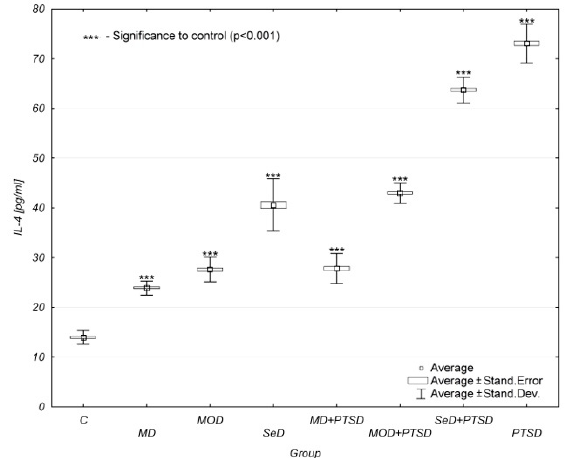
Figure 3. Mean IL-4 concentration levels in selected study groups. Legends: C—control group, MD—mild depression; MOD—moderate depression; SD—severe depression; MD + PTSD—mild depression n+ posttraumatic stress disorder; MOD + PTSD—moderate depression + posttraumatic stress disorder; SeD + PTSD—severe depression+ posttraumatic stress disorder;